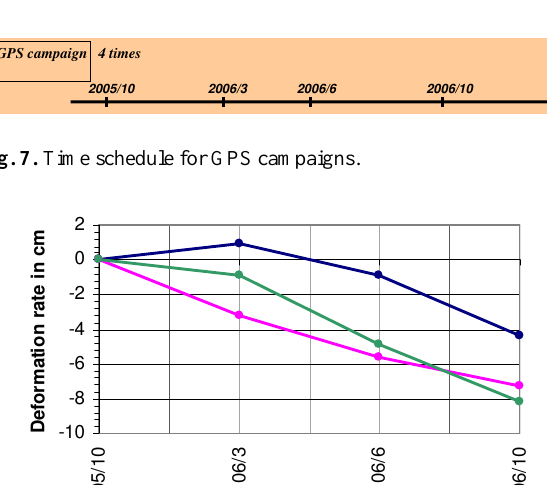
Figure 7. Time schedule for GPS campaigns